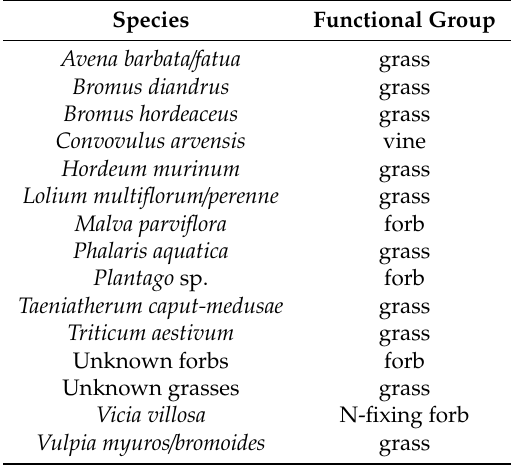
Table 2. Non-native species found within the study